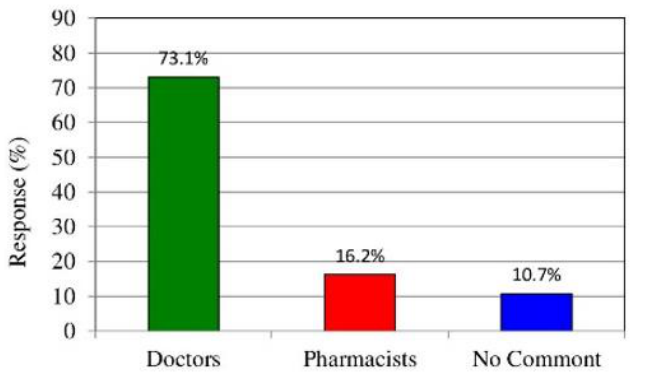
Figure 4. Perception of pharmacists. Customers’ views on societal respect of pharmacists ( A ). Customers’ preferences of doctor or pharmacist for the provision of drug therapy consultation ( B ).